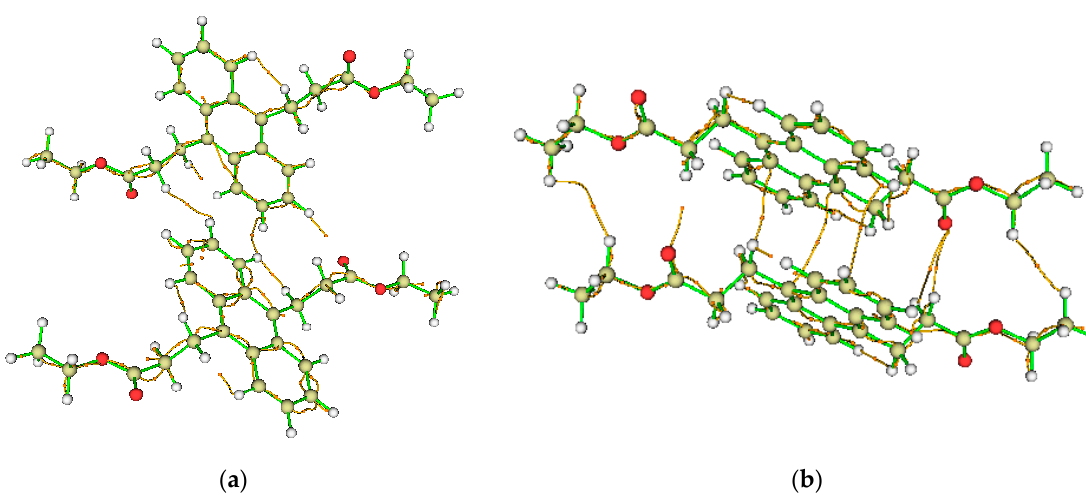
Figure 15. Molecular graph of the frontal ( a ) and axial ( b ) interactions between DEADP molecules in the crystals, where the orange lines correspond to the bond path, and the small orange circles to the bond critical point.